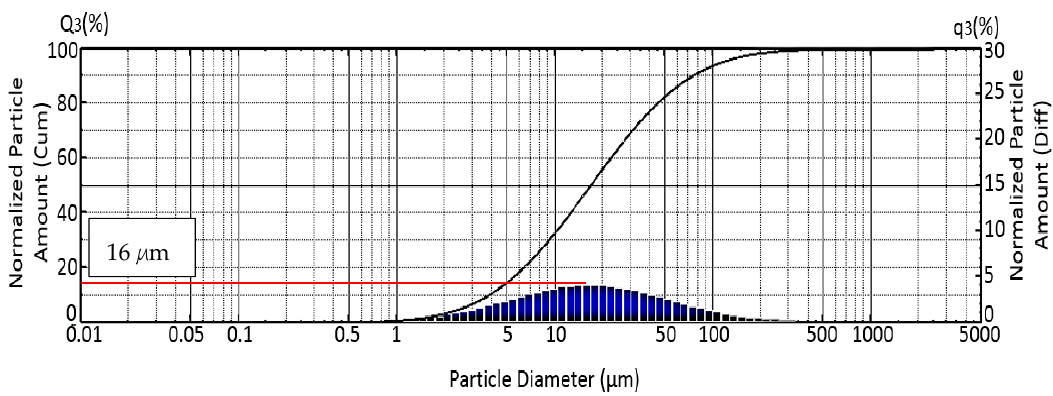
Figure 2. Particle size analyzer results for Gr powder. The red line shows the average size of graphite particles.